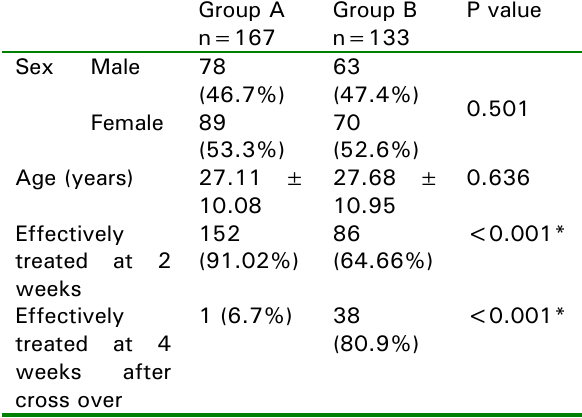
Table 3: Comparison of group A and group B at 2 nd weeks and 4 th weeks of treatment